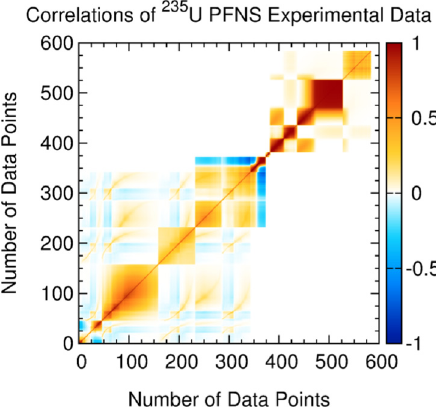
Fig. 5. Correlation matrix across four (4) different experimental data sets for the thermal neutron-induced prompt fi ssion neutron spectrum of 235 U. Correlations across different experiments are clearly visible below about N =350 points. Figure taken from Neudecker et al.